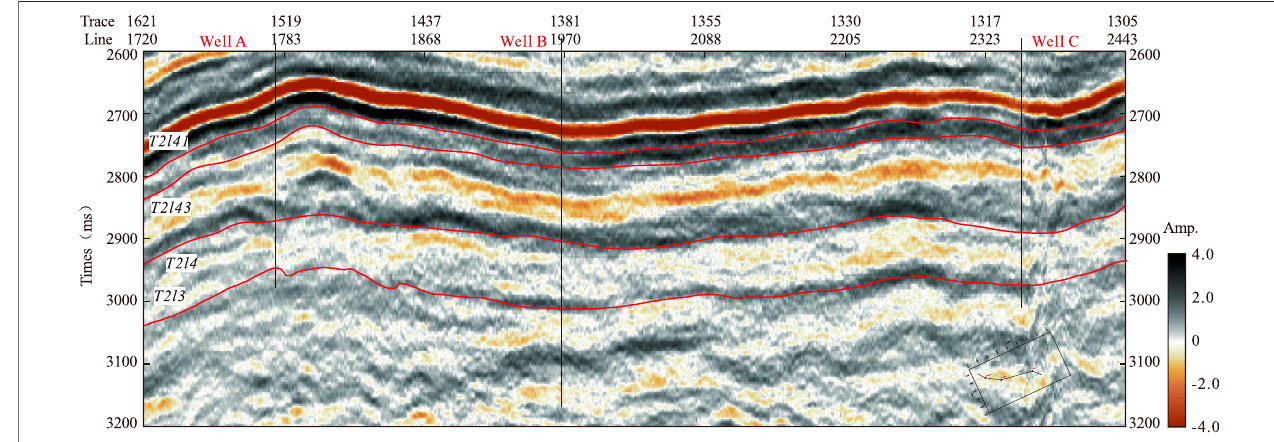
FIGURE 9 | Seismic pro fi le of the wells in the study area.